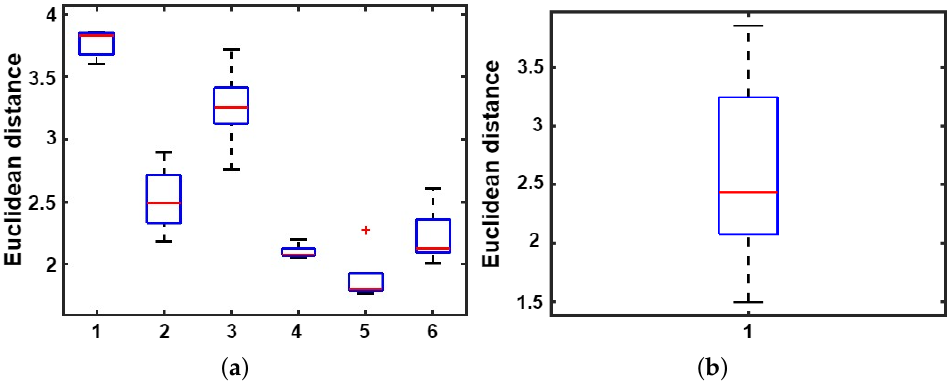
Figure 18. Euclidean distance between the UGV and the trap for the UGV validation. ( a ) Presents a box plot per experiment. ( b ) Single graph with data from all